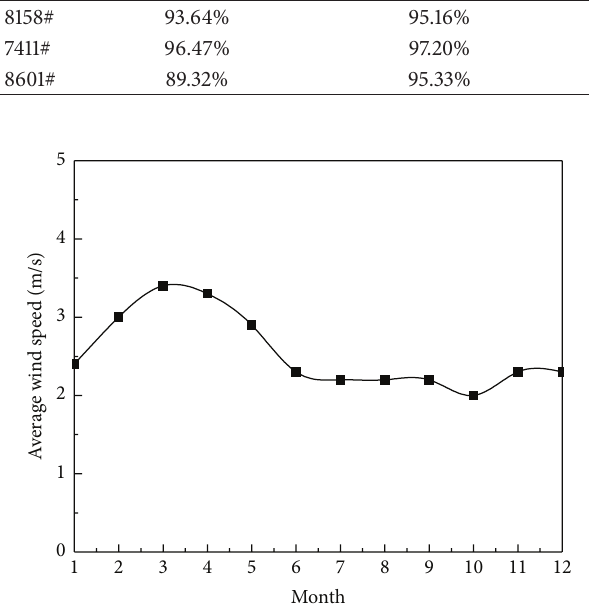
Figure2:Monthaveragewindspeedduring1981–2010yearinGuaz- hou meteorological